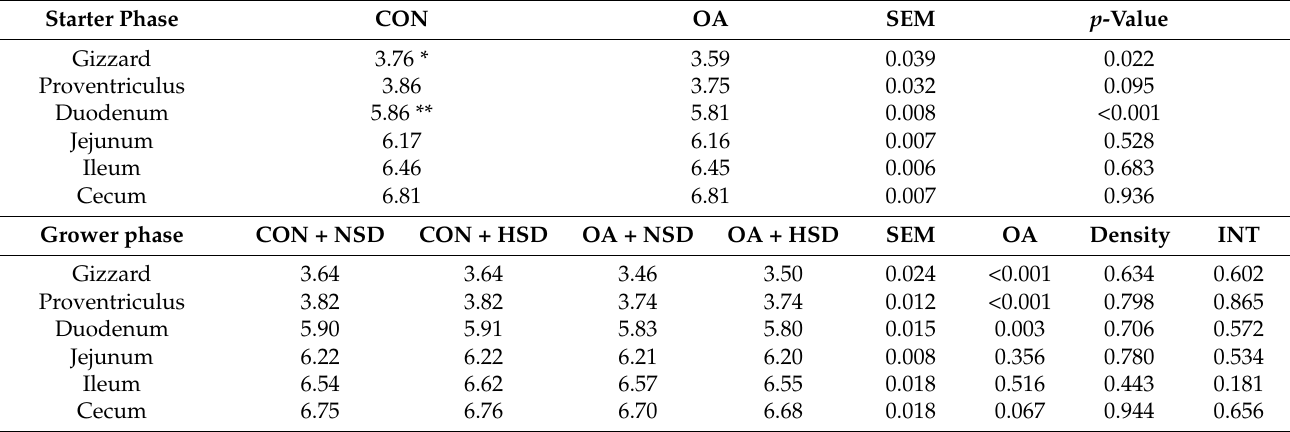
Table 3. Effects of organic acids on the chyme pH values in broilers at starter and grower phases 1